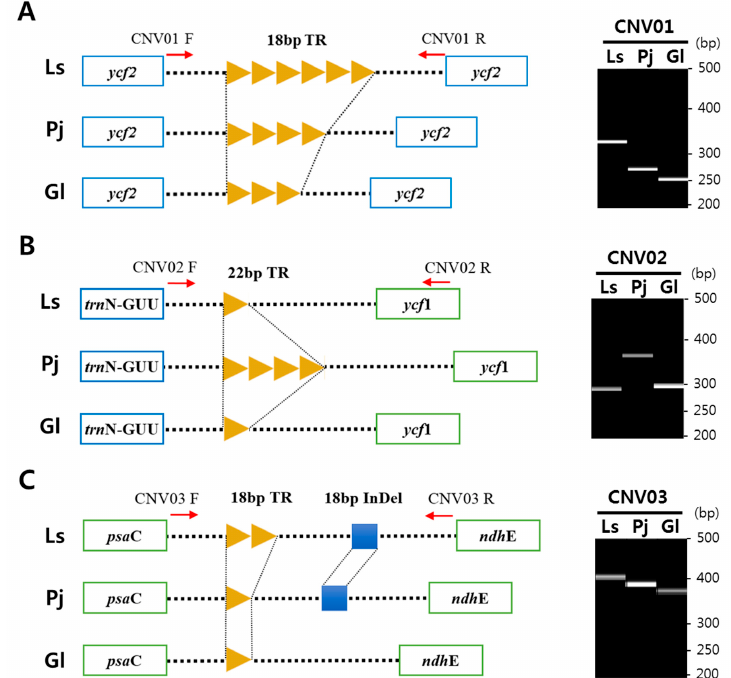
Figure 5 . Schematic diagram and digital gel images from capillary electrophoresis of barcode markers derived from copy number variations (CNVs) of tandem repeat (TR) units in chloroplast genome. ( A